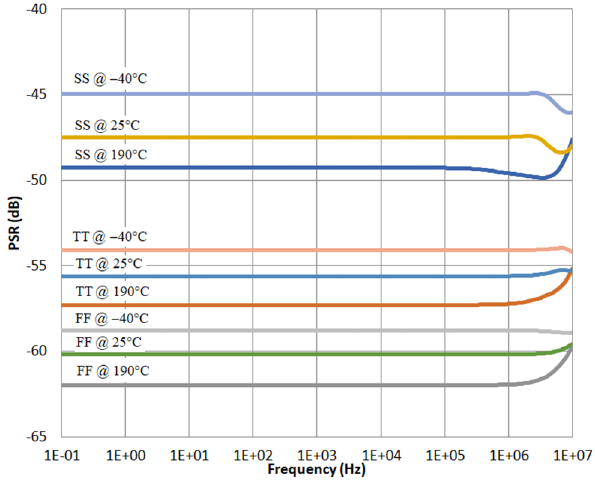
Figure 9. Corner analysis of power supply rejection, or PSR , at three temperatures and maximum supply of 24 V.